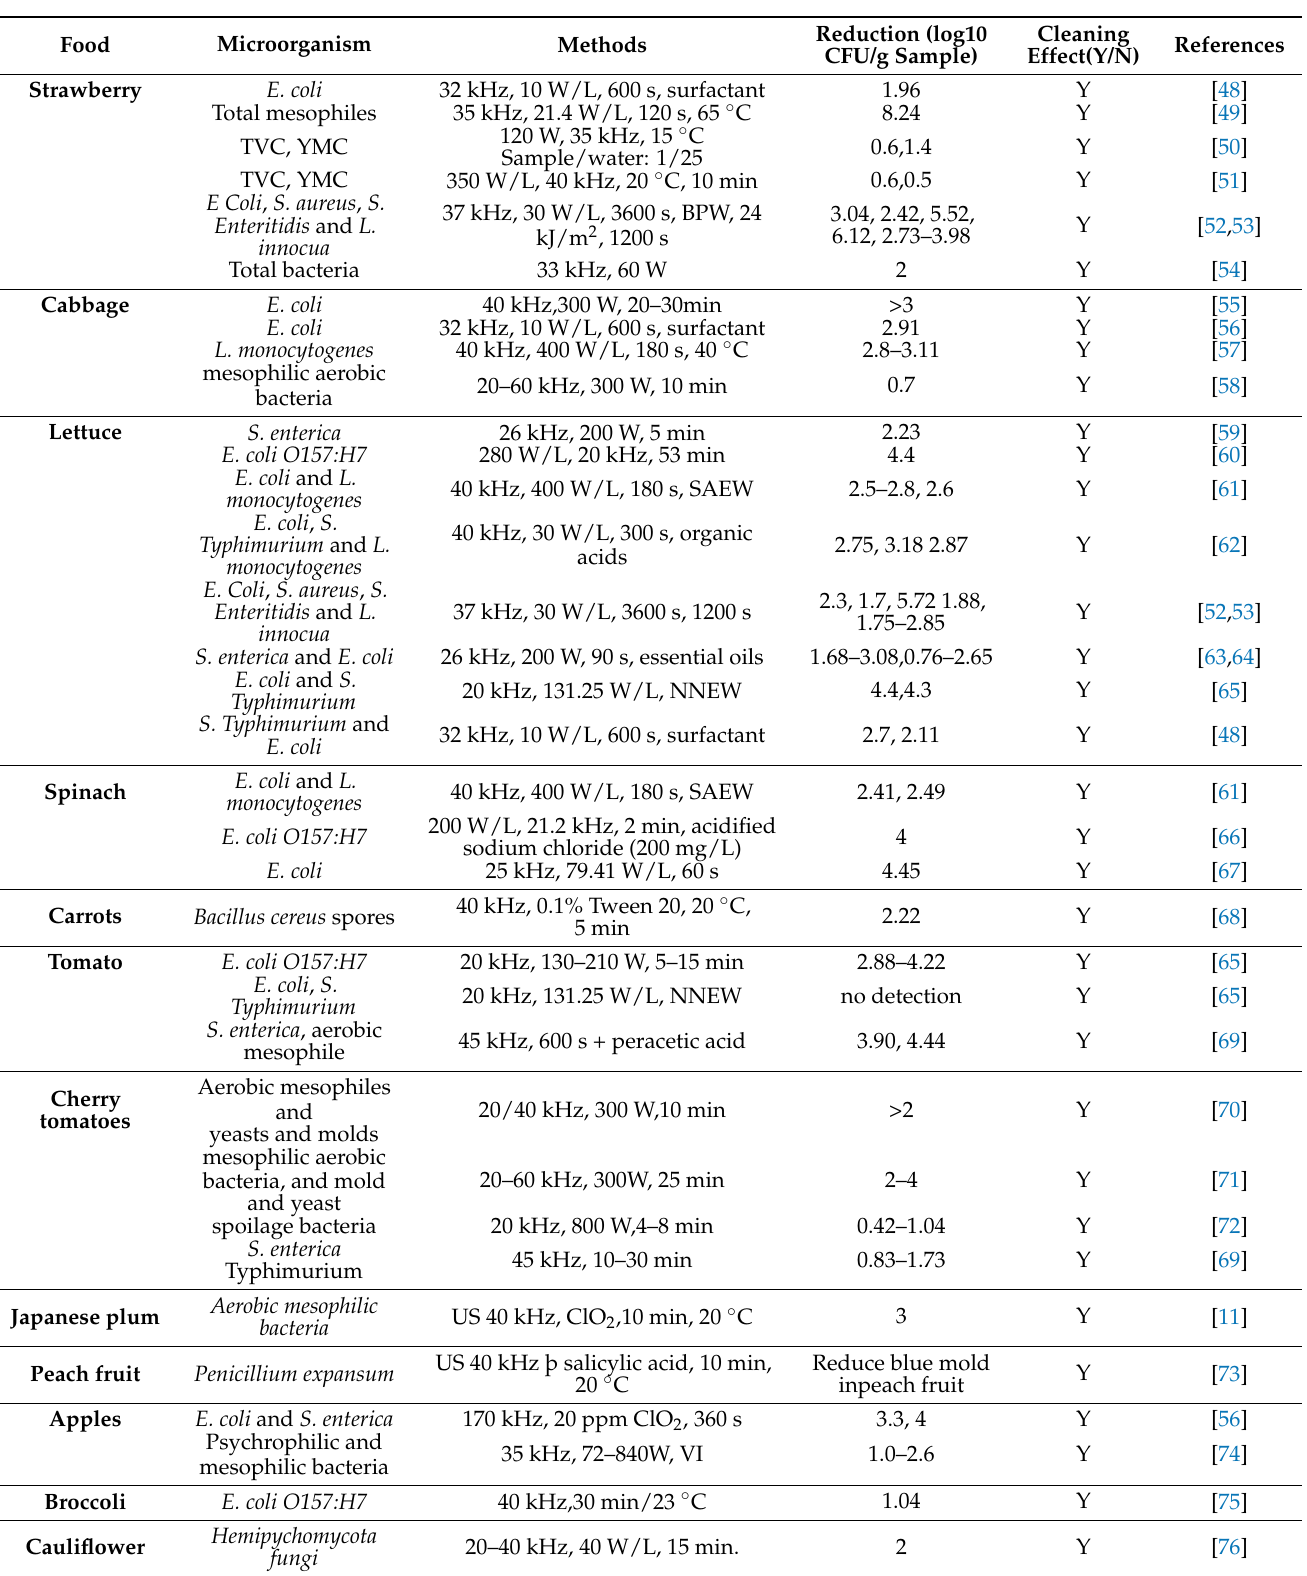
Table 1. Ultrasound cleaning technology of whole fruits and